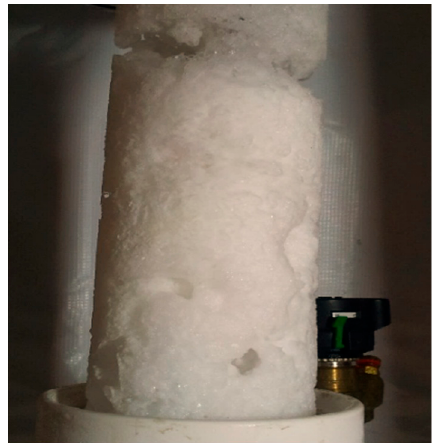
Figure 5. Stabilized propane hydrate.